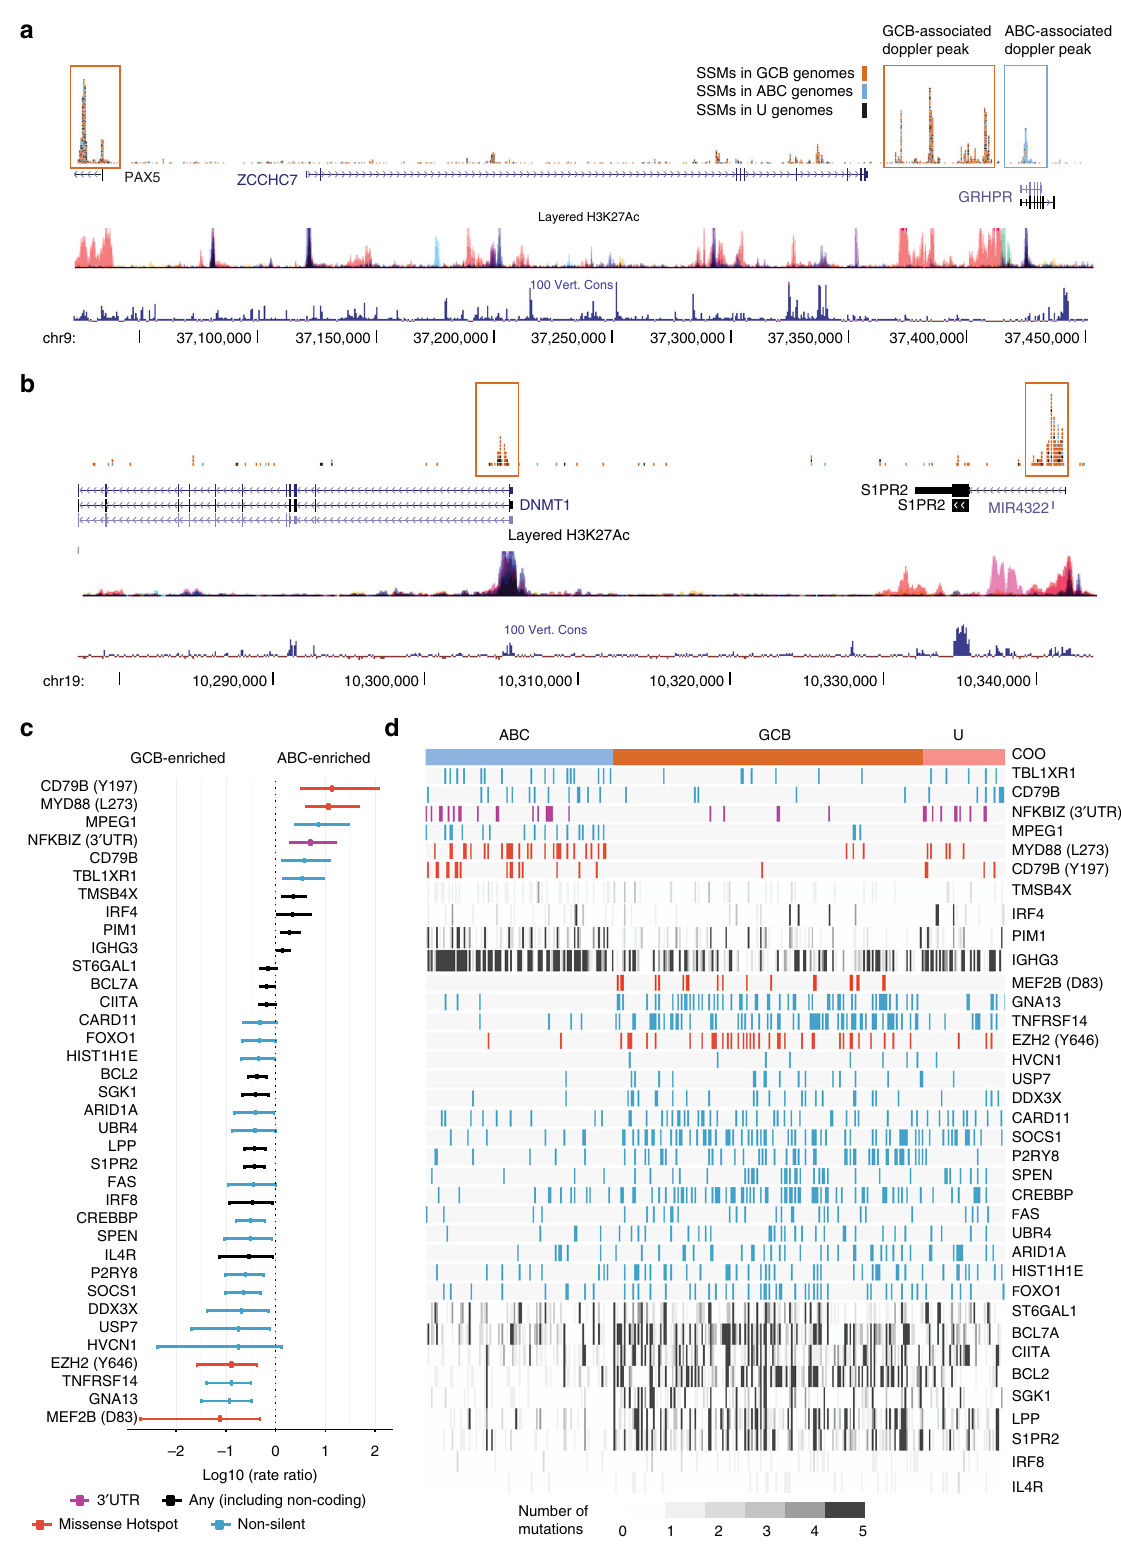
(Supplementary Figure 6A; Supplementary Data 6). The bulk of mutations in many of these loci affected introns, the 5 ′ UTR or upstream of the TSS, and unsurprisingly, many were known aSHM targets discussed above (Fig. 2a; Supplementary Figure